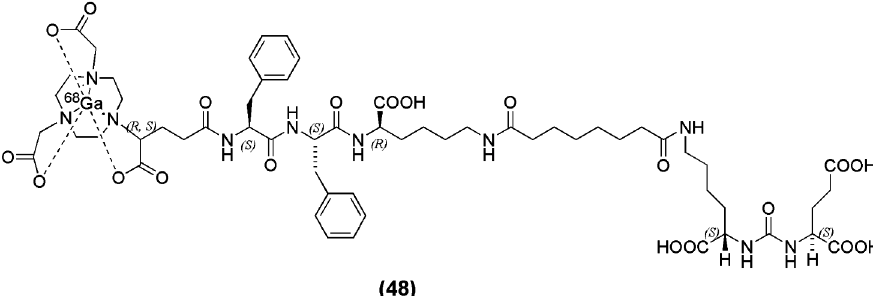
Figure 15. Chemical structure of 68 Ga-( R )-NODAGA-Phe-Phe- D -Lys(suberoyl)-Lys-urea-Glu ( 68 Ga-CC34) ( 48 )